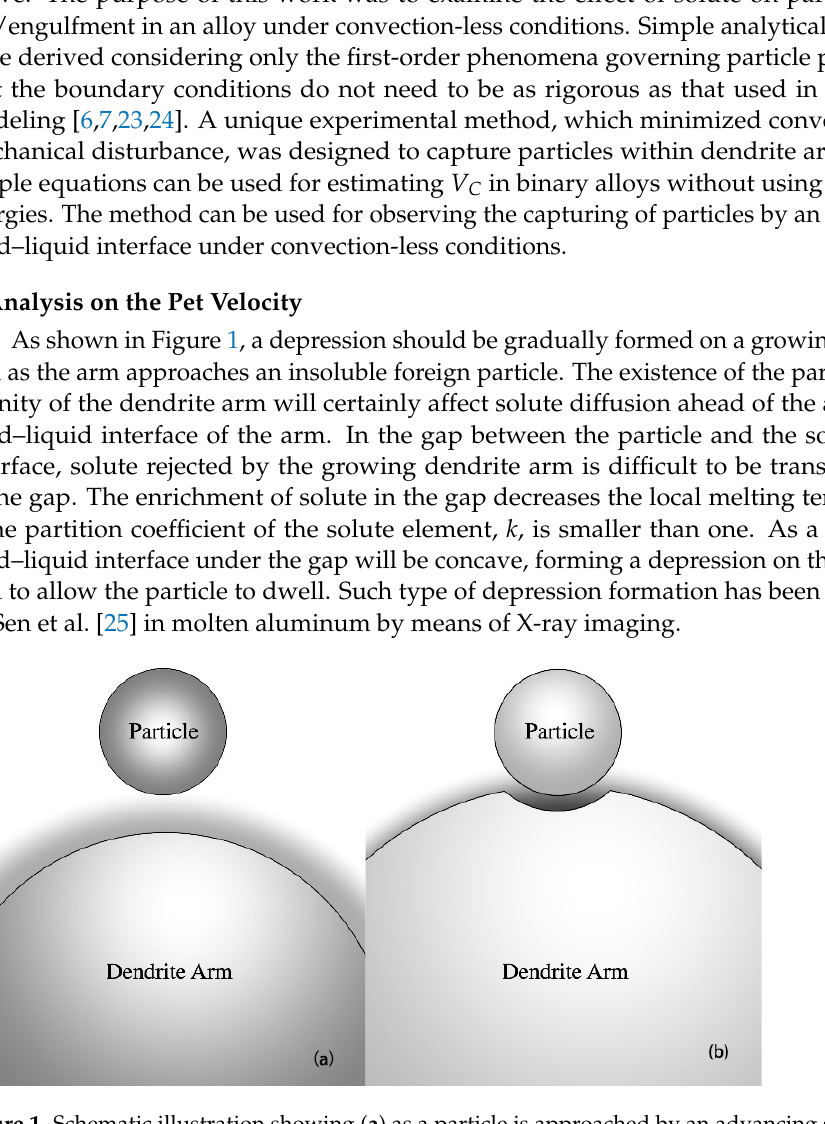
Figure 1. Schematic illustration showing ( a ) as a particle is approached by an advancing solid–liquid interface of a dendrite arm, ( b ) a depression is formed on the growing dendrite arm if k < 1. The shade indicates the solute field ahead of the solid–liquid interface of the dendrite arm. The solute concentration is illustrated as proportional to the darkness of the shade.